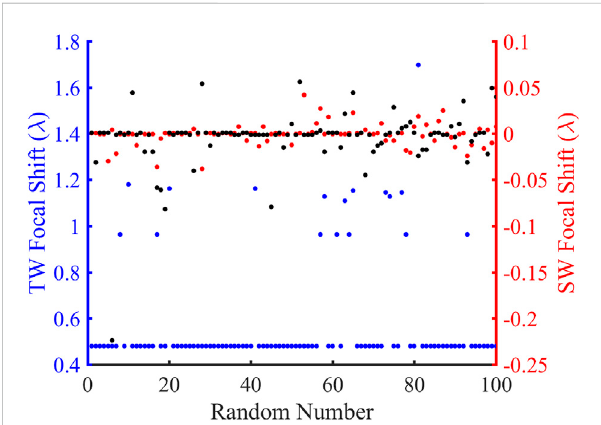
FIGURE 7 Comparison of the focus shifts in the traveling wave (TW) and standingwave(SW)modesover100randomsimulations.Theblueand red ordinates are the TW and SW focus offsets, respectively, and the abscissarepresentstherandomnumber.Theblue,black, andred dots represent the focal shift distributions for TW at 680.2 kHz, SW at 680.2 kHz, and SW at the corresponding resonant frequencies,